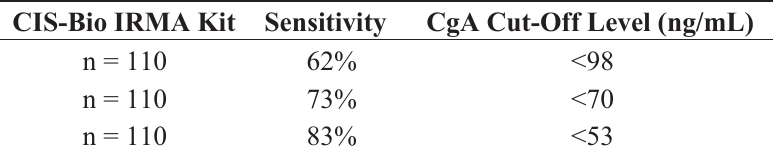
Table 1. Sensitivities of CgA depending on different cutoff levels in our study population (CIS-bio IRMA kit).